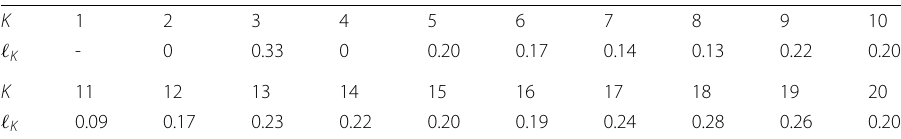
Table 9 FBsoc: evolution of (cid:6) K